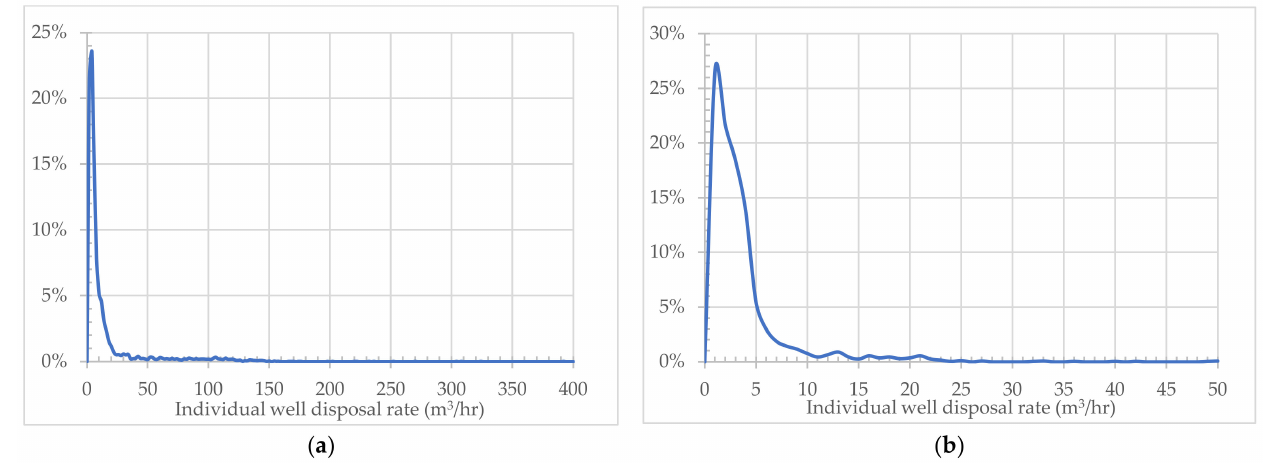
Figure A22. Historical per-well water injection rate ( X -axis) frequency ( Y -axis) distributions (January 1962–December 2022) in ( a ) the Elkton Formation; ( b ) the Turner Valley Formation.